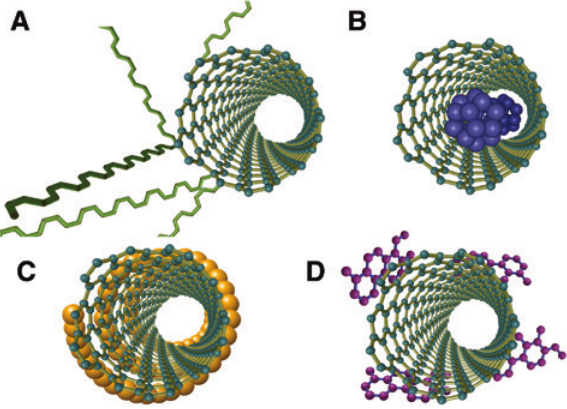
Figure 2: Types of chemical functionalisation: (A) covalent func- tionalisation; (B) endohedral functionalisation; (C) non-covalent polymer wrapping; (D) non-covalent